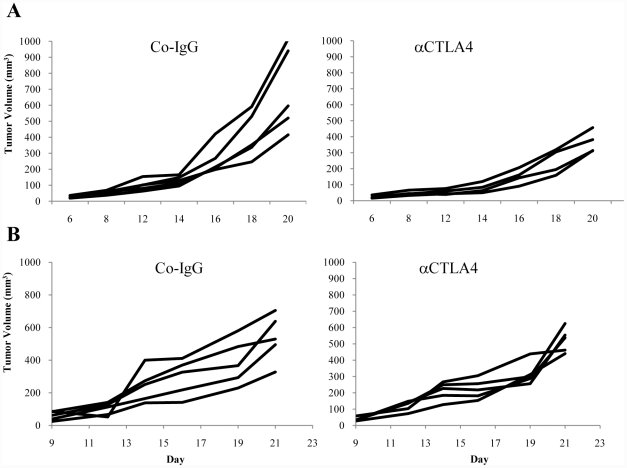
Effect of anti-CTLA4 antibody injection on MMC and TC-1 tumor growth.
A) C57Bl/6 mice with subcutaneous TC-1 tumors were injected with 100 µg anti-CTLA4 and control IgG antibody intraperitoneally (i.p.) every other day. Treatment was started when tumor reached a volume of 50 mm3. Tumor volumes were measured thrice a week. Each line represents an individual animal. p<0.05 for time points after day 16. B) neu-transgenic mice with subcutaneous MMC tumors were treated as described in A). The difference between the two groups was not significant.